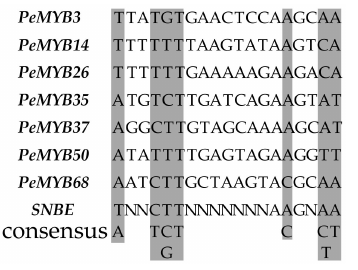
Figure 7. Diagram of the secondary wall NAC binding element (SNBE) sequences in the 2.0-kb promoters of PeMYB s. The consensus nucleotides in the SNBEs were shaded and the consensus SNBE sequence was shown at the